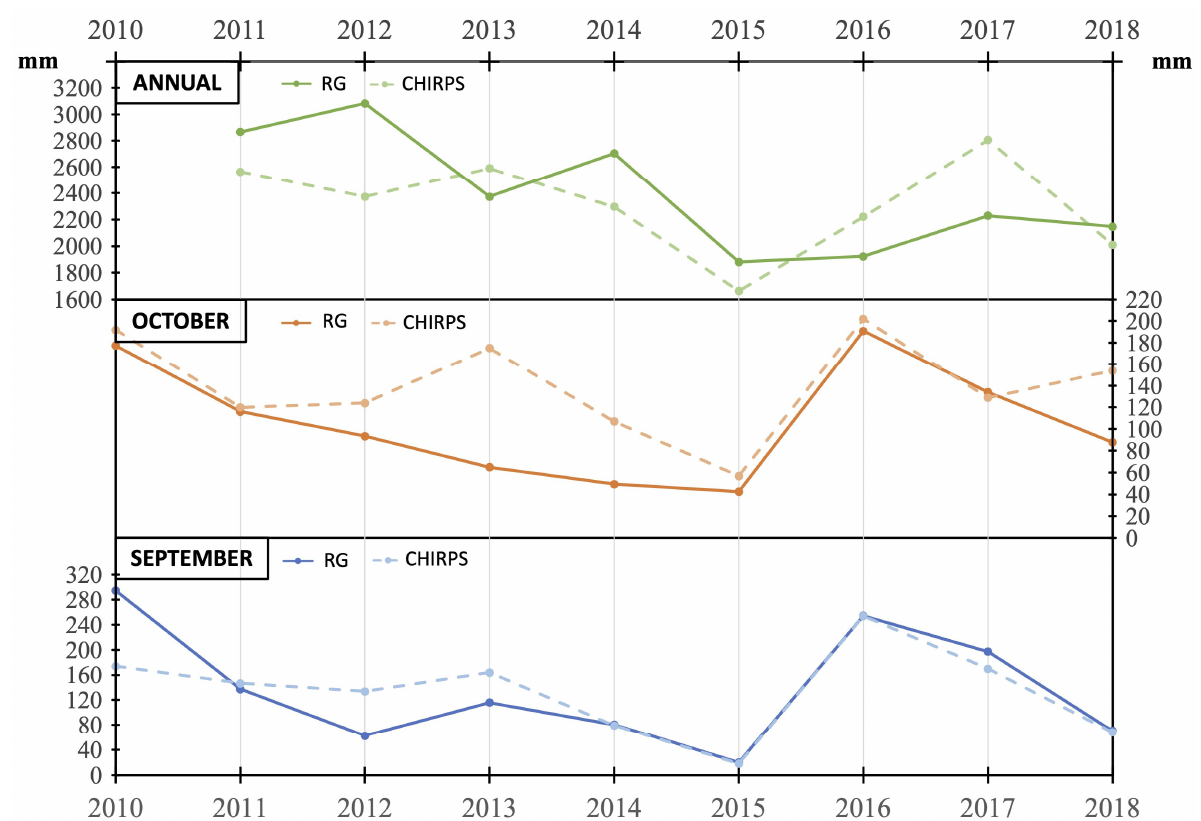
Figure A2. Comparison of rainfall estimates (CHIRPS) and rain gauge observations (RG) at the Bendili research station in Kutai National Park for annual, September, and October time periods between 2010–2018. Bendili RG observations are courtesy of the Orangutan Kutai